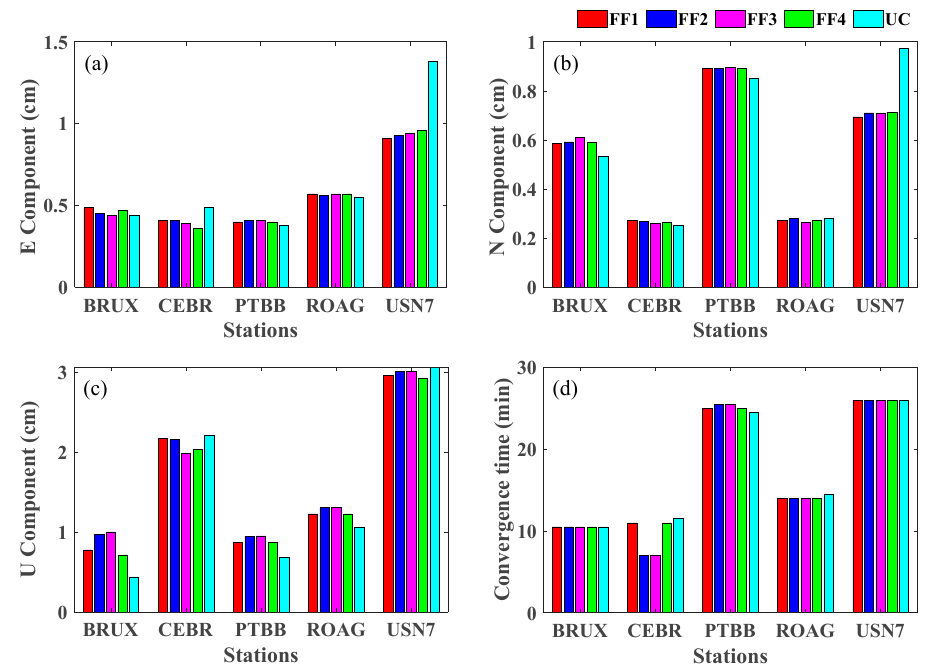
Figure 8. Positioning performance of the BRUX, CEBR, PTBB, ROAG and USN7 stations by the FF1, FF2, FF3, FF4 and UC PPP solutions on DOYs 190 to 196 in 2020. ( a ) E Component RMS value; ( b ) N component RMS value; ( c ) U component RMS value; and ( d ) convergence time.